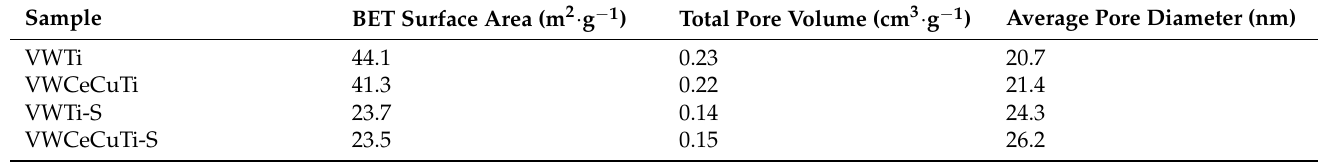
Figure 2. XRD patterns of fresh and S-poisoned catalysts. Table 1. Textural properties of fresh and S-poisoned